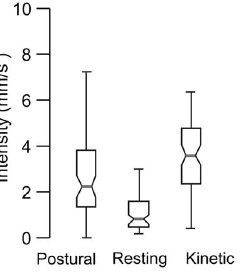
Figure 5. Comparison of the median intensities of non-tremor, rapid, and adventitious movements in 79 A–T subjects. Each box-whisker plot depicts one condition. Grey horizontal line depicts median value, notches correspond to 95% confidence interval, box lengths depict quartile values, and whiskers depict